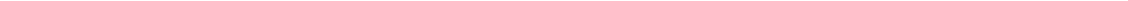
changes of autophagy and neuropathology. Inhibition of